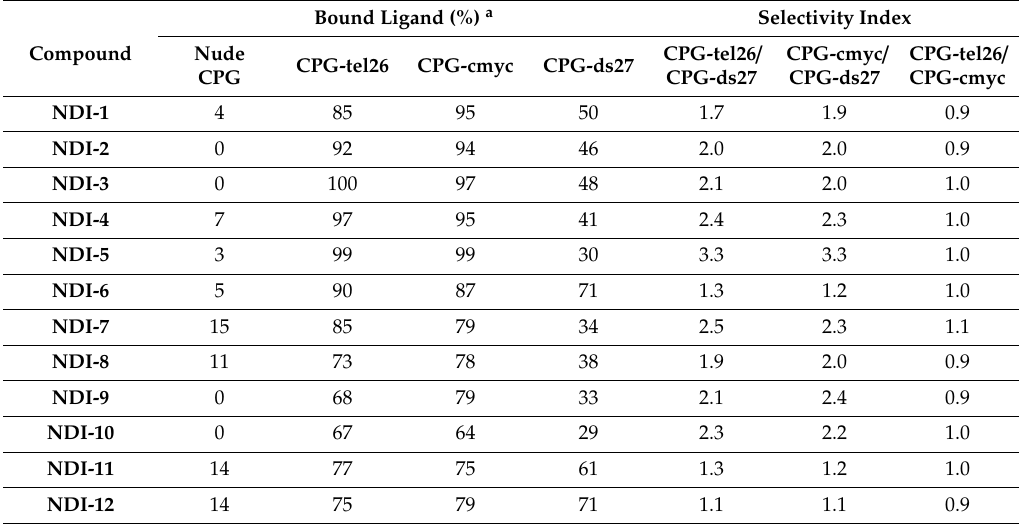
Table 1. Summary of the binding assays’ data for monomeric and dimeric NDIs on nude and functionalized CPG supports, and selectivity indexes calculated as the ratio between the percentages of ligand bound to the indicated G4- and hairpin duplex-functionalized